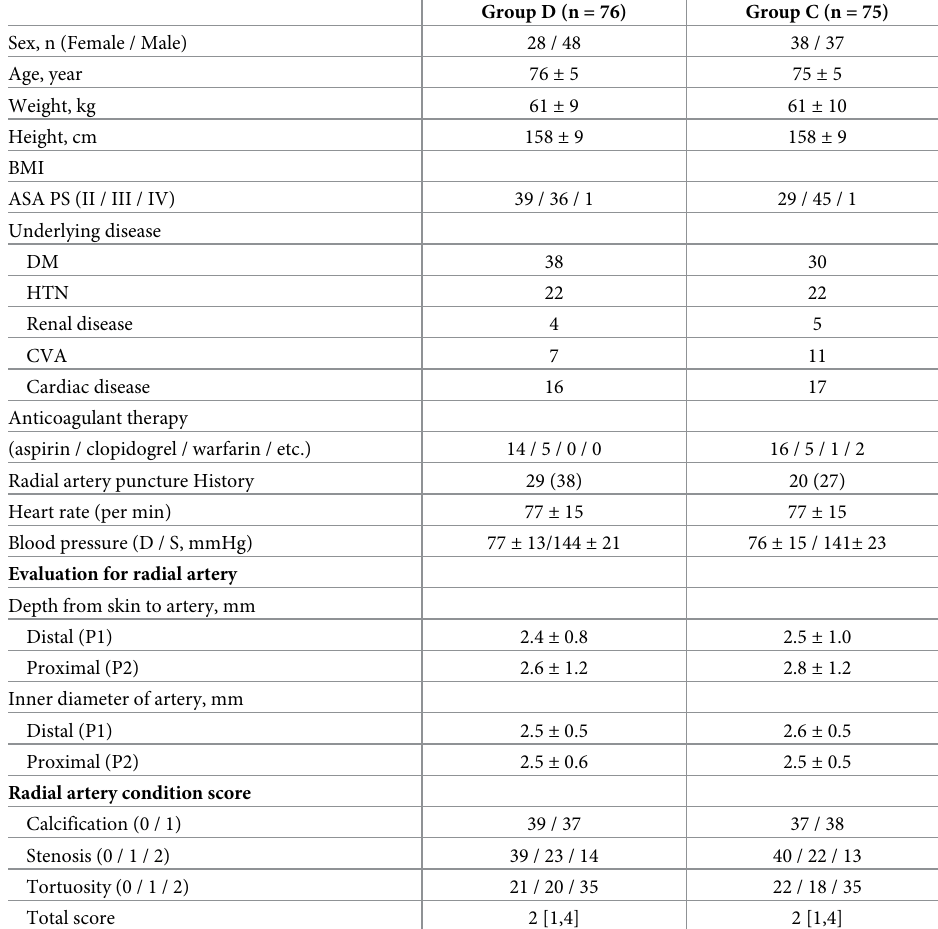
Table 1. Patient